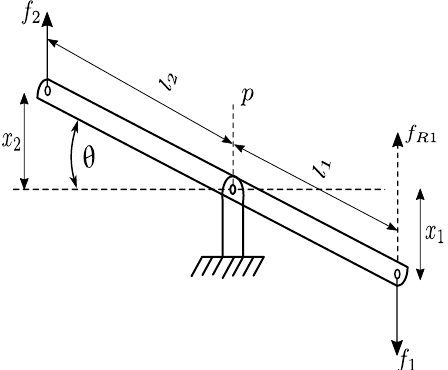
Figure 6. Schematic diagram of the lever device.